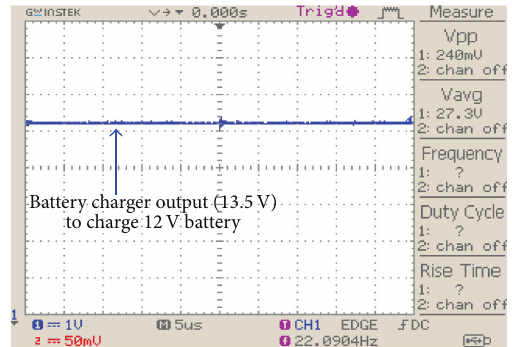
Figure 30: Experimental output of battery charge controller.